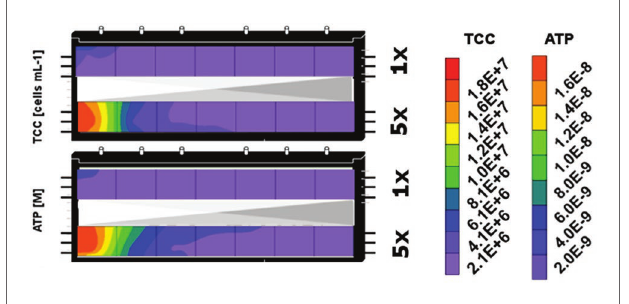
FIGURE 6 | Spatial distribution of sediment bacterial biomass (TCC) and activity (ATP) in the sediment zones that received DOM-1x (here upper segment) and DOM-5x (lower segment) feeding solution at the end of the experiment (t171). The contour plots combine data from sediment segments of the two microcosms that were subject to similar DOM